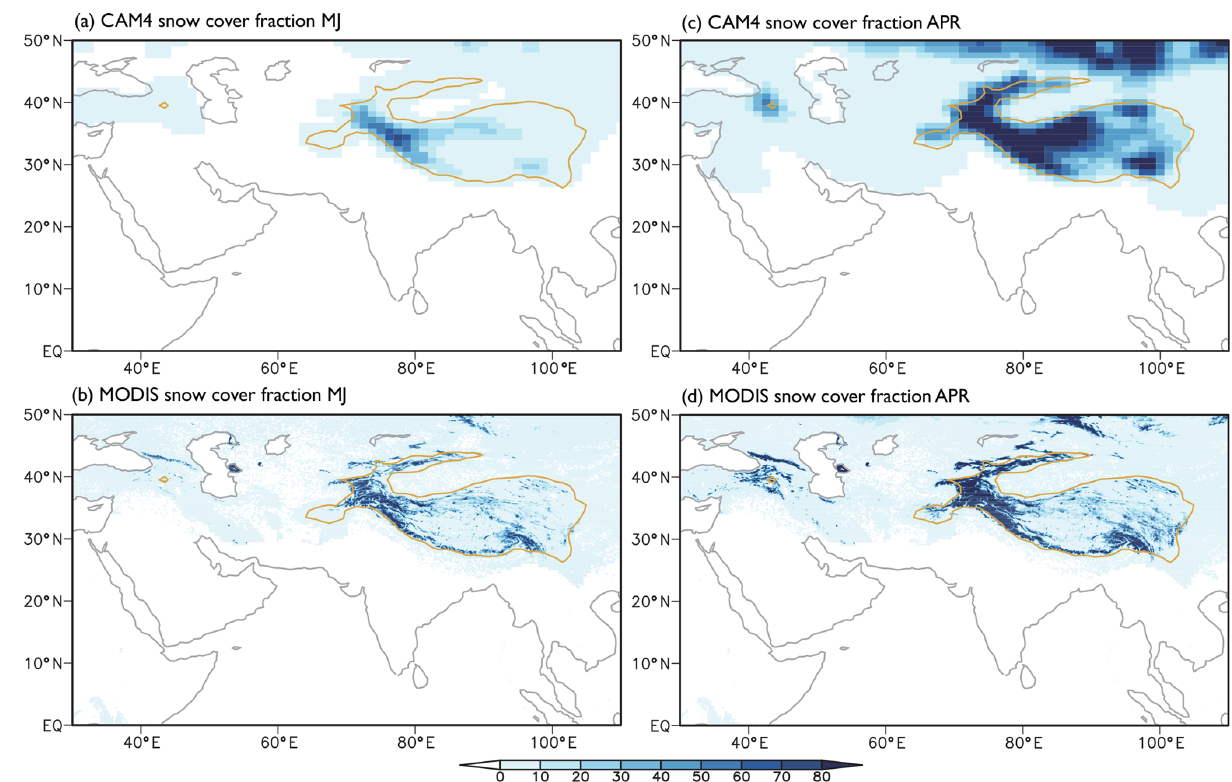
Figure 2. Snow cover fraction (%) over Asia in CAM4 (a, c) and in Moderate Resolution Imaging Spectroradiometer (MODIS)-retrieved observation (b, d) for May to June and for April, respectively. Yellow line shows the profile of the Tibetan Plateau above